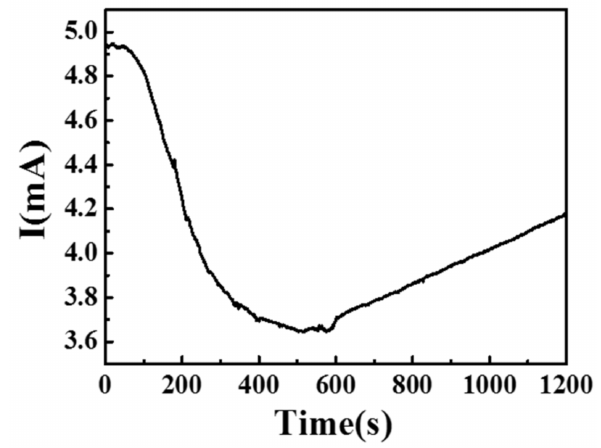
Figure 13. Current variations with and without water molecules at 150 ◦